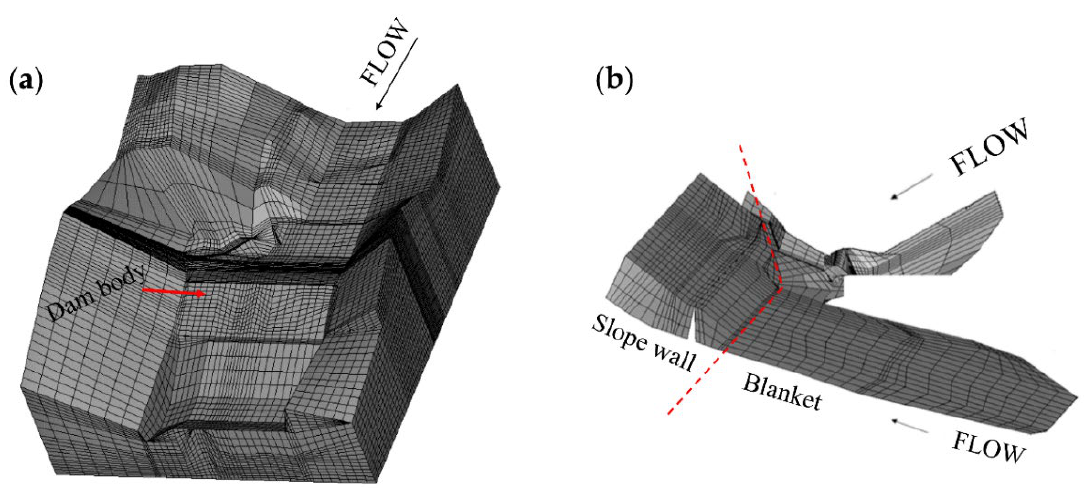
Figure 4. Finite element mesh models. ( a ) The whole dam. ( b ) The compound geomembrane.